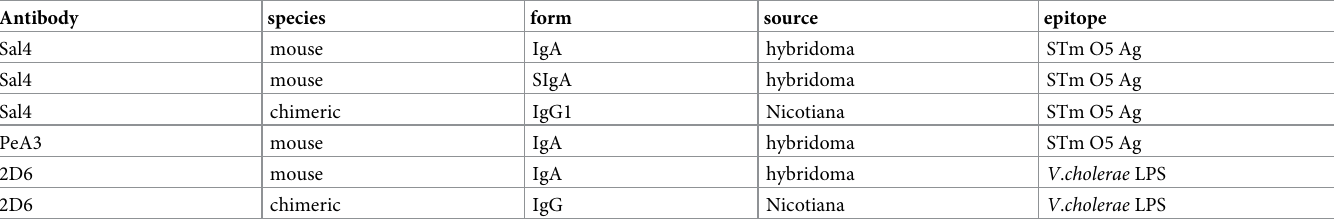
with PBS containing 0.1% Tween-20 (PBST) and 2% goat serum for 2 h at room temperature before washing with PBST. Plates were developed using goat anti-mouse and goat anti-human TMB Microwell Peroxidase Substrate (KPL, Gaithersburg, MD). For the whole-bacteria ELISA, 96-well NUNC MaxiSorp plates were coated with poly-L-lysine (10 μ g/ml) overnight at 4˚C. Overnight cultures of STm were washed twice with PBS and then placed into each well Table 2. Anti-ST and control mAbs used in this study.